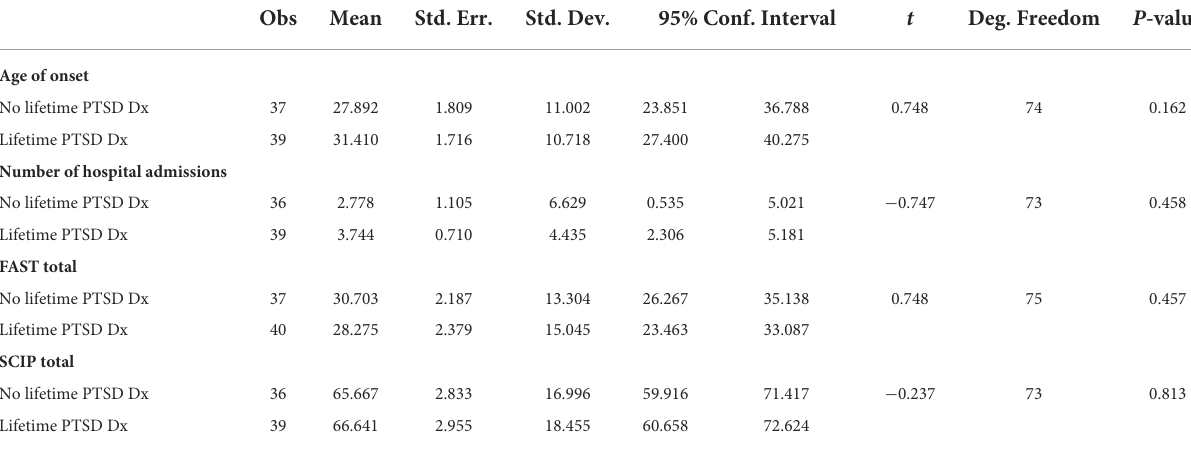
TABLE 4 Impact of lifetime diagnosis of PTSD on quantitative variables of disease course. Obs Mean Std. Err. Std. Dev. 95% Conf. Interval t Deg. Freedom P